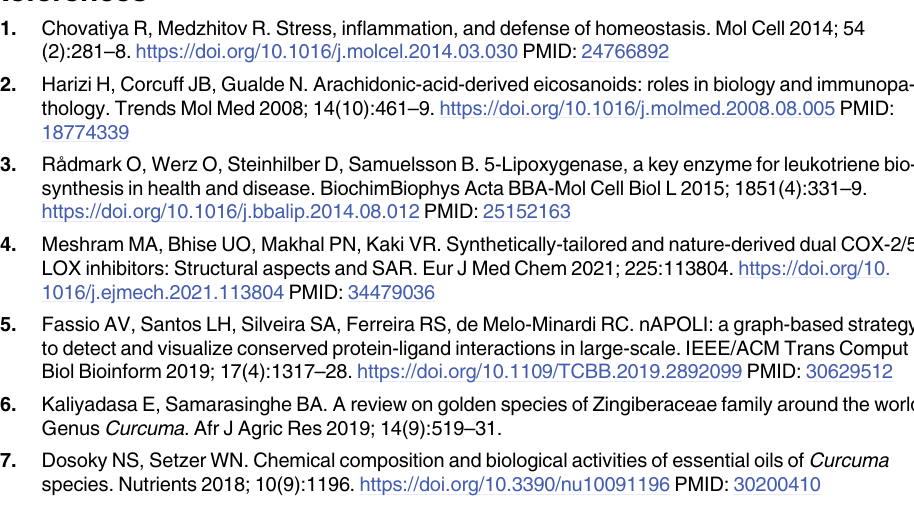
S5 Fig. Structural superimposed view of the 5-LOX protein (before MD: Green) with MD simulated protein after 100 ns seconds (cyan). (DOCX) S6 Fig. The evolution of secondary structure elements of 5-LOX protein during 100 ns pro- duction MD in lipid bilayers. The plot was generated using timeline module of VMD. S7 Fig. The development of secondary structural components of 5-LOX proteins α -Terpin- eol, α -turmerone, β -turmerone, and dihydrocarveol over 100 ns production MD in lipid bilayers. The plot was created with VMD’s timeline